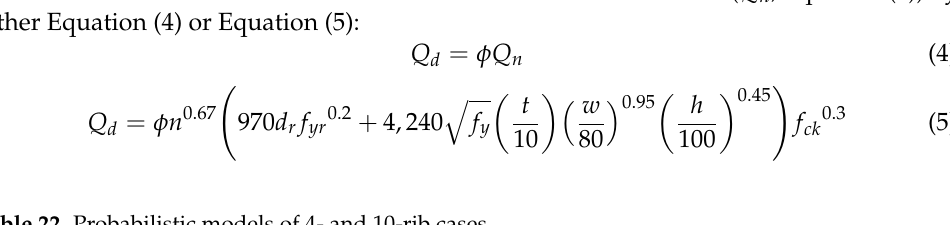
Table 22. Probabilistic models of 4- and 10-rib cases.